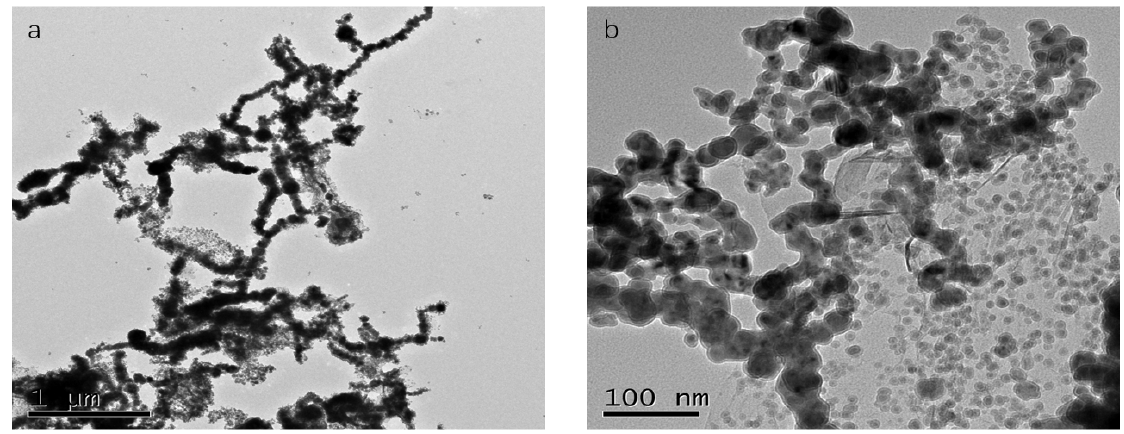
Figure 6. TEM images of Fe/Cu ( a ) and rGO/Fe/Cu ( b ).